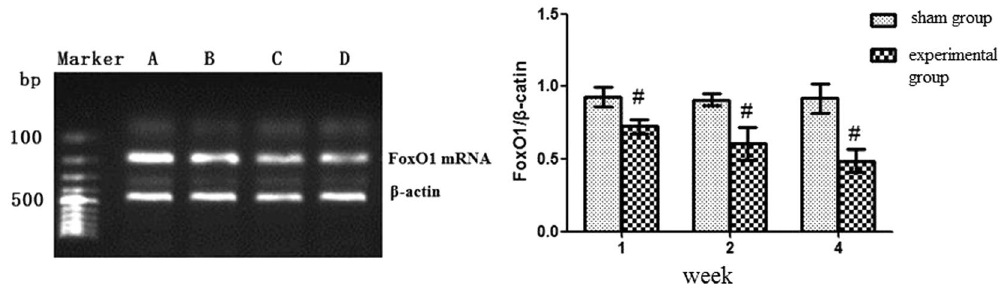
Figure 4. FoxO1 mRNA expression in the rat CTEPH model. Note: ( A ) Sham group; ( B ) 1-week experimental subgroup; ( C ) 2-week experimental subgroup ( D ) 4-week experimental subgroup. # P < 0.05 , compared to sham group within the same